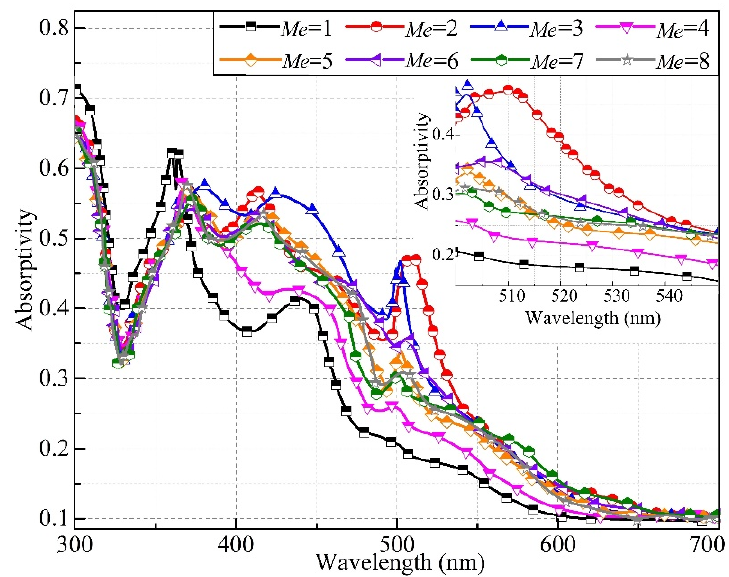
Figure 5. The Me precision analysis of computational model.